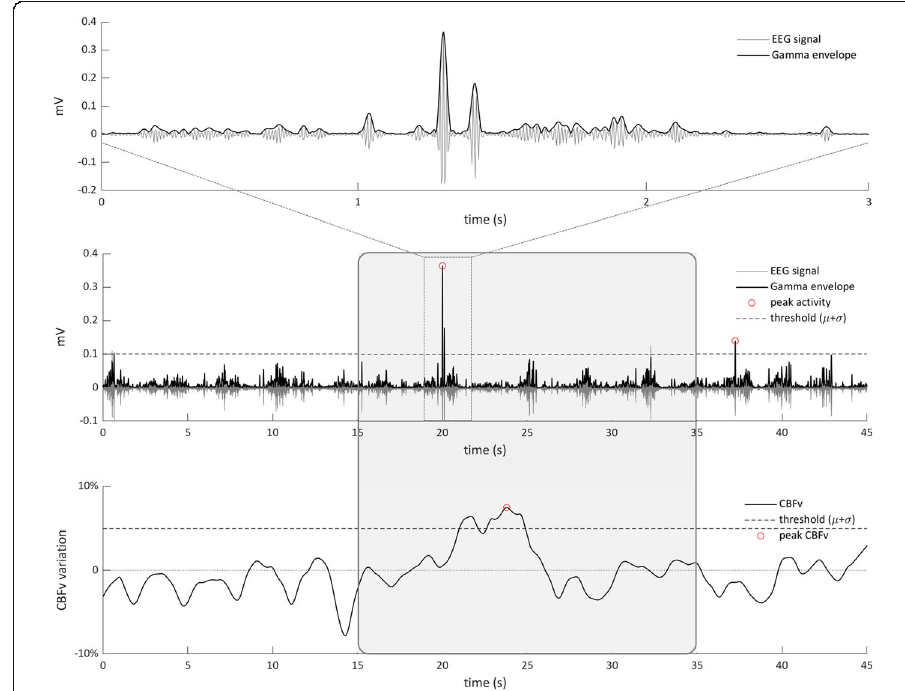
Fig. 1 Schematic of analysis techniques used to identify neural events for selecting epochs of the accompanying hemodynamics. Magnification of the gamma filtered EEG signal and the corresponding envelope (E γ ) of a peak of neuronal activity (top row). A 45s E γ trial from a single animal is shown as an example (middle row); two peaks of neuronal activity above the chosen threshold are marked. A time epoch of 20s around the first peak is drawn. Corresponding 45s of CBFv fluctuation from the same animal (bottom row); an increase in the CBFv appears few seconds after the E γ